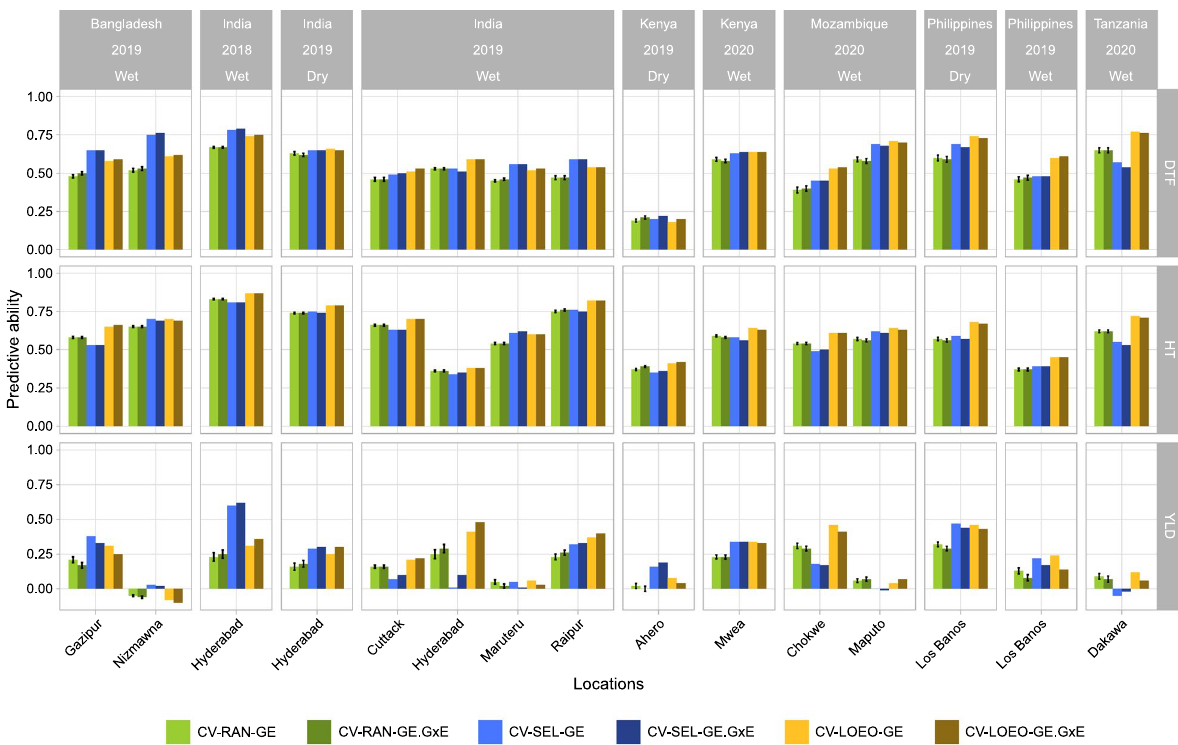
Fig. 6 Comparison of the predictive abilities between the three cross‑validation scenarios: CV-RAN (random), CV-SEL (selected environments) and CV-LOEO (leave one environment out). Two models are presented: the first one with only the main effects of genotypes and environments (GE) and the second one with the main effect and the interaction (GE of PA values from 50 replicates. DTF days to flowering; HT plant height; YLD grain yield